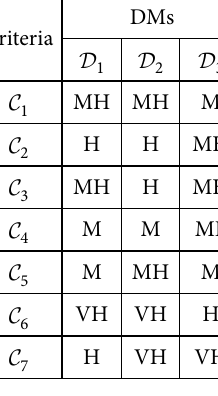
Table 3. Weights of the cri- teria evaluated by the DMs Criteria